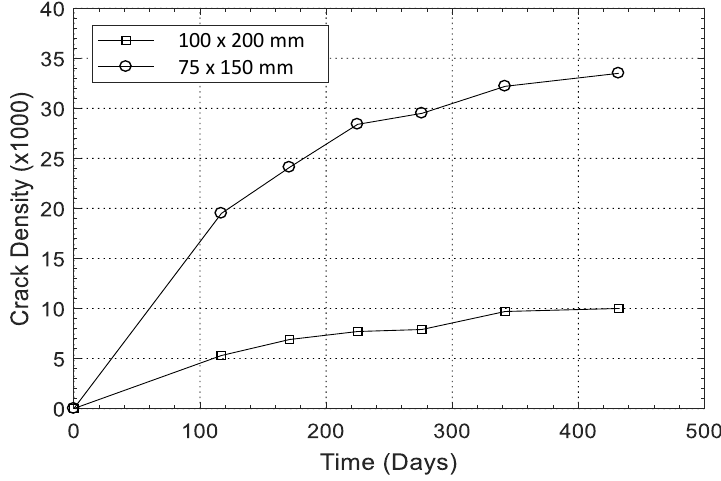
Figure 7. Crack density versus time for NaOH concrete cylinder samples.